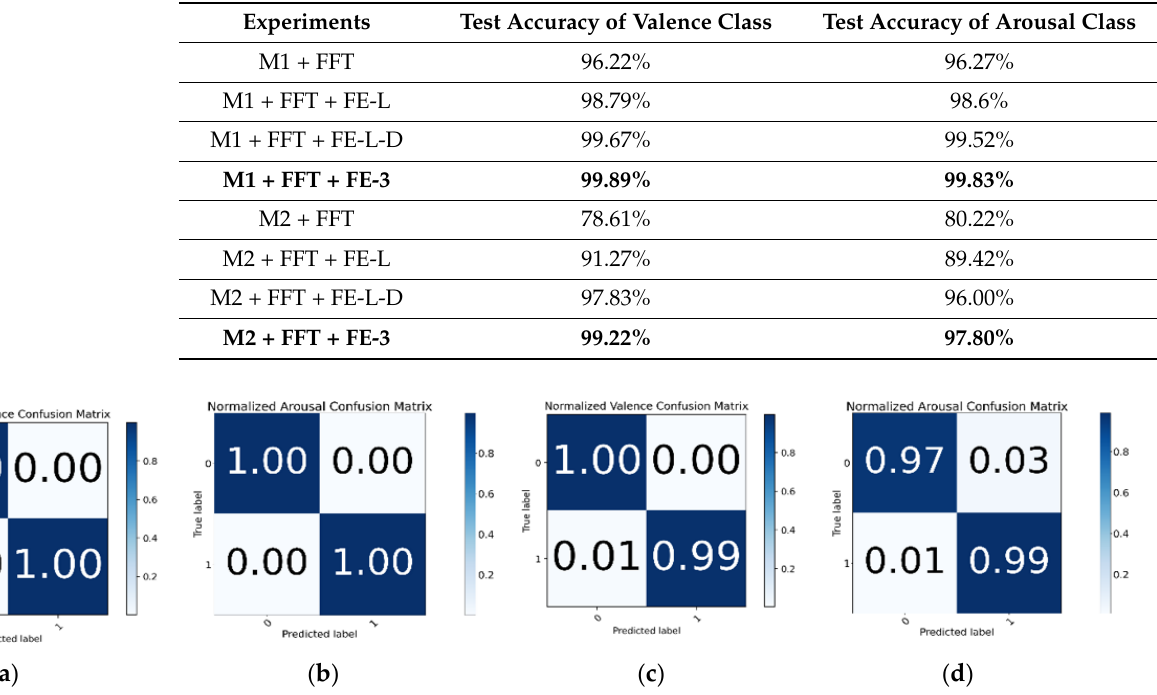
Table 8. Results summary of heavy (M1) and light (M2) 1D CNN models with feature extraction and feature extension.